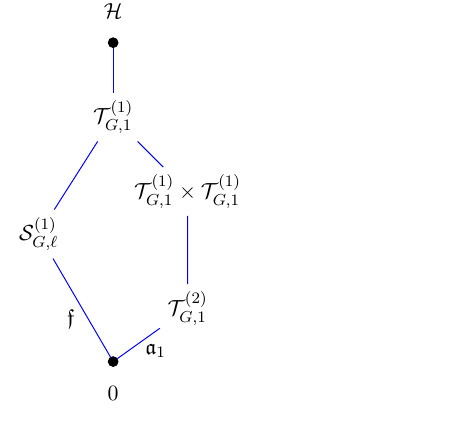
. (a) is for ‘ =2, 4 and 6 while (b) is for ‘ =3 and 5. G;‘